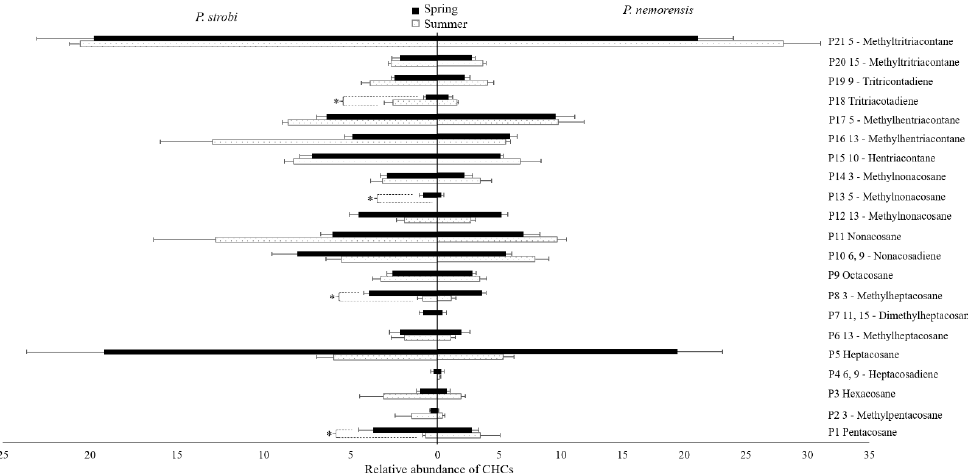
Figure 3. Relative abundances of the CHCs on the body surface of female Pissodes strobi and Pissodes nemorensis females in spring and summer populations. Mean ± SE; n = 5. The bars in black and white represent the relative abundances of the CHCs extracted from the females in spring and summer populations, correspondingly. * Indicates a significant di ff erence in the relative abundances of each component between spring and summer females at α =